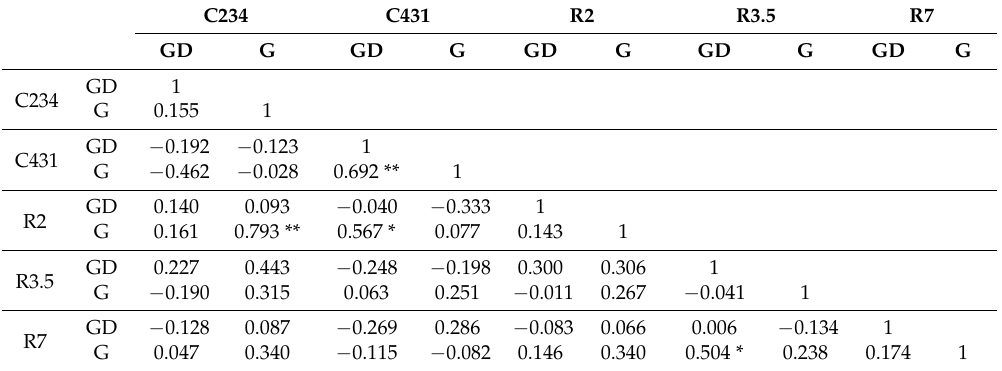
Table 2. Correlations of time spent on gesture development (GD) and gesturing (G) during simulation. C234 C431 R2 R3.5 R7